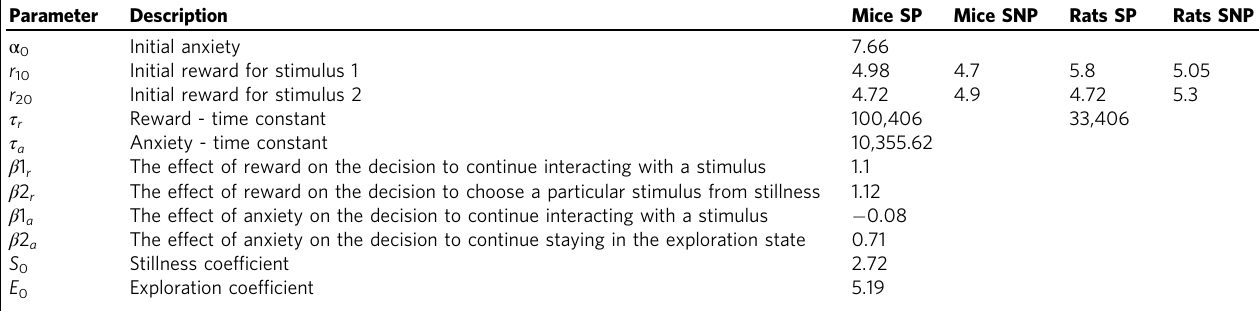
Table 2 Fixed model parameters and their